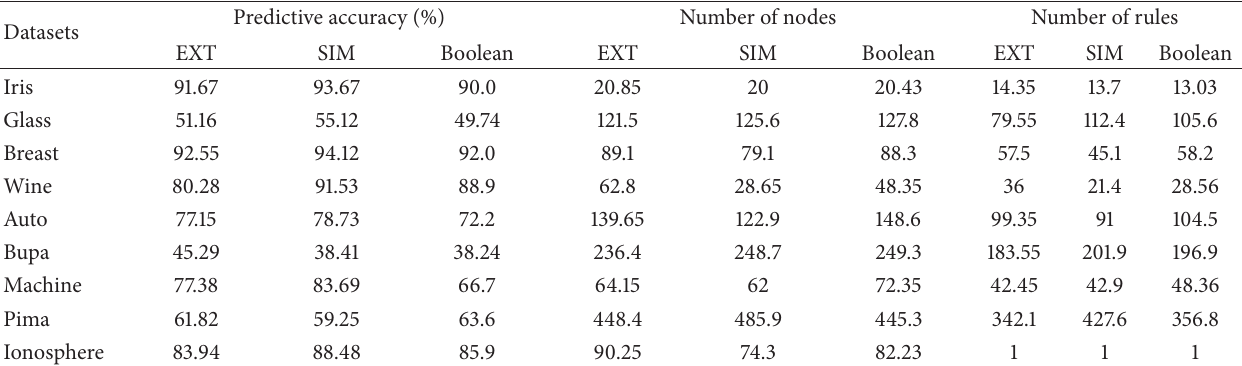
Table 3: Comparison of C4.5 performance on 9 UCI real